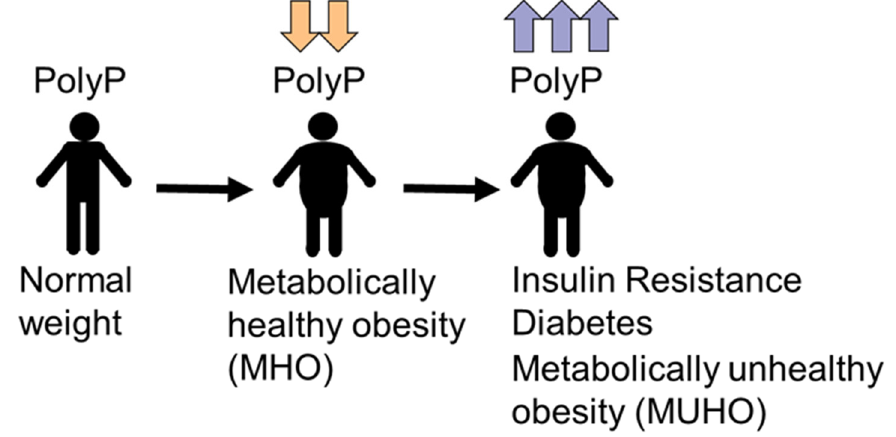
Figure 4. Proposed model of the variations in plasma polyphosphate in obesity, insulin resistance, and diabetes. In metabolically healthy individuals, plasma polyP tends to decrease with overweight and obesity. With the onset of insulin resistance and diabetes, polyP increases because individuals became metabolically unhealthy.